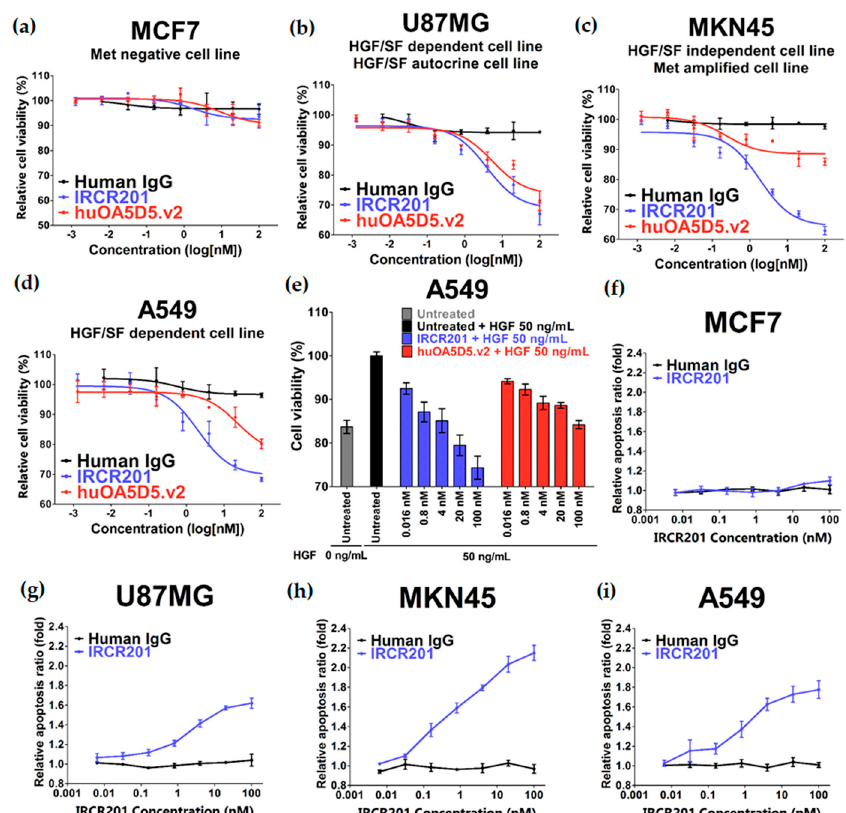
Figure 5. In vitro potency of IRCR201. All results are shown as the mean ± standard error of mean (SEM) from triplicate treatments. ( a – d ) Inhibitory effect of IRCR201 on cancer cell proliferation. MCF7, U87MG, MKN45, and A549 cells were treated with IRCR201, huOA5D5.v2, or human IgG control for 72 h. Cell proliferation was measured using CellTiter Glo ® (Promega); ( e ) HGF-induced growth inhibition by IRCR201. The inhibitory effect of IRCR201 and huOA5D5.v2 on cell growth was examined under the condition of the addition of 50 ng/mL HGF in A549, an HGF-dependent cell. After 72 h of antibody treatment, the number of cells was measured with CellTiter Glo ® (Promega); ( f – i ) Apoptosis assay. MCF7, U87MG, MKN45, and A549 cells were treated with IRCR201 or human IgG for 24 h. Apoptosis activity was detected with caspase-3/7 activity.